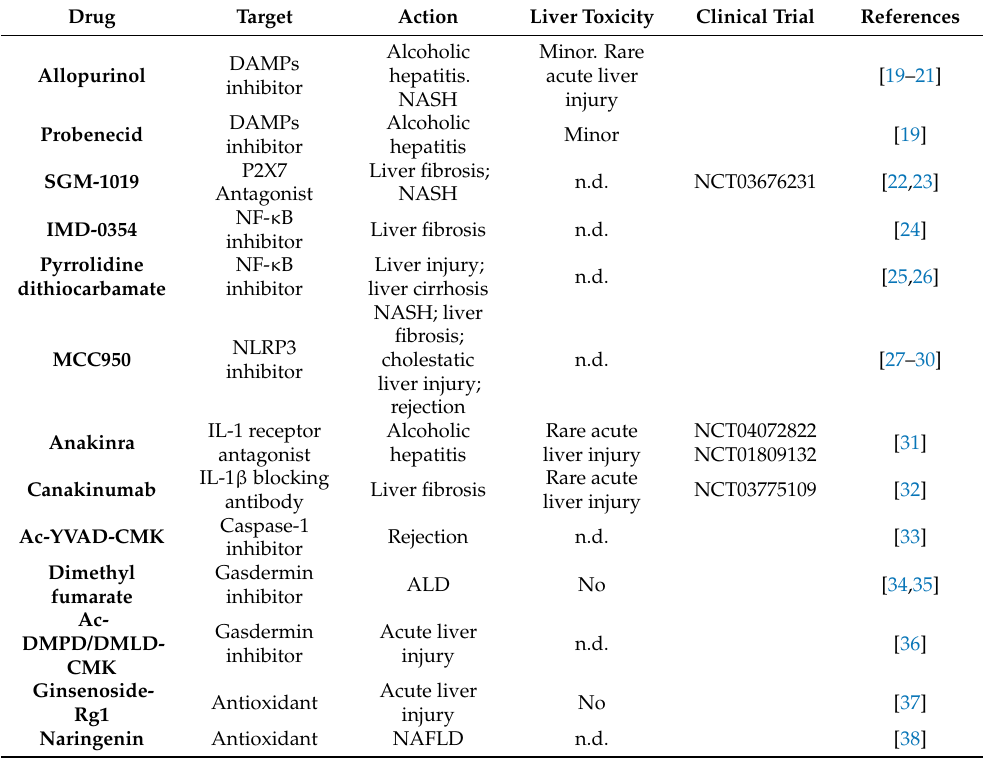
Table 1. List of the principal drugs targeting the NLRP3 inflammasome and pyroptosis pathway with protective action in liver